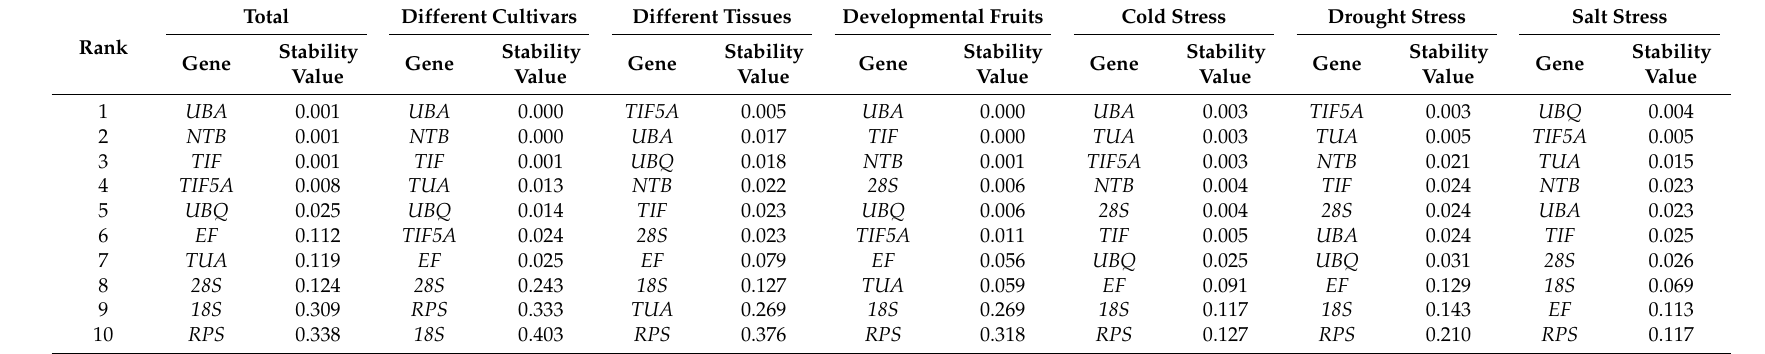
Table 4. Stability analysis of candidate reference genes, as assayed with NormFinder